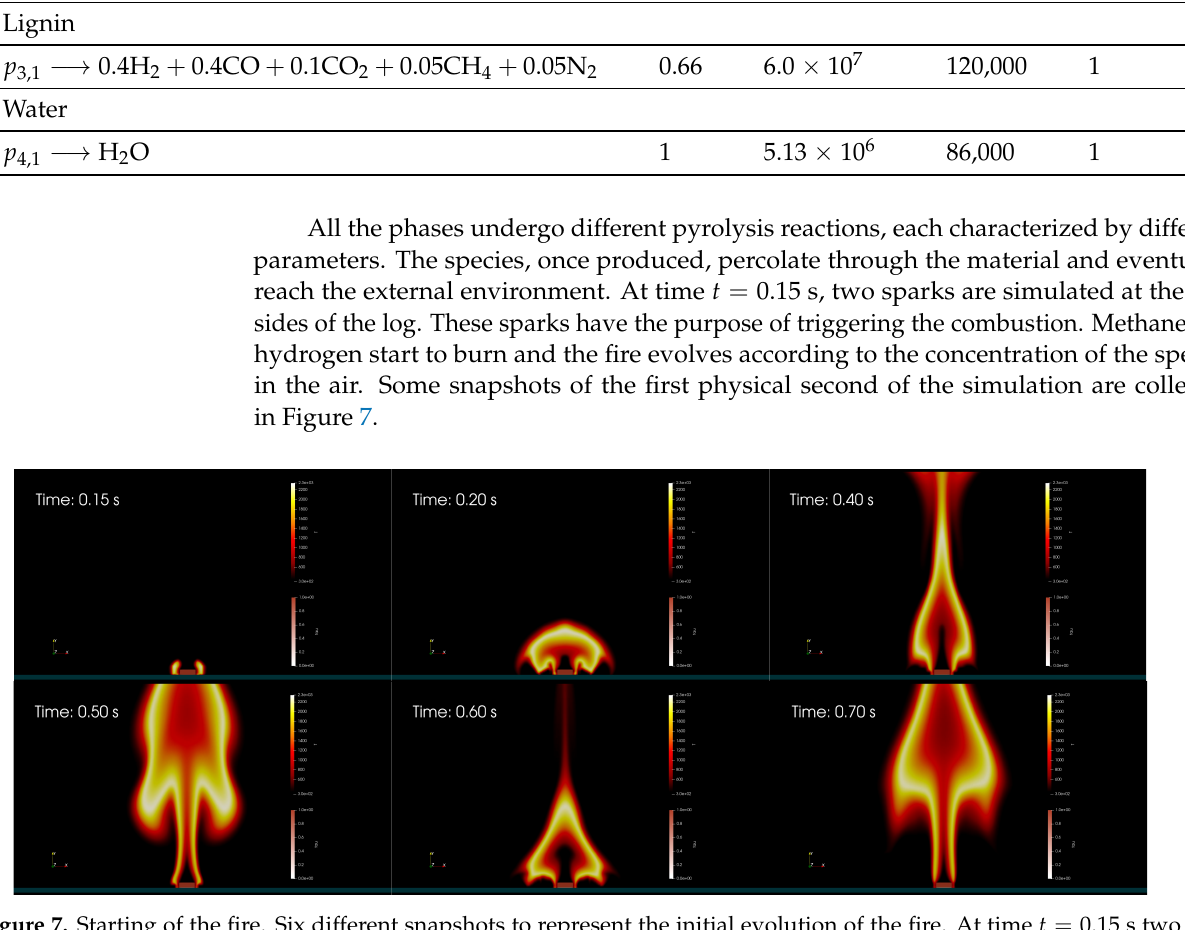
Figure 7. Starting of the fire. Six different snapshots to represent the initial evolution of the fire. At time t = 0.15 s two sparks are generated on the side of the wood log to trigger the combustion. A fire is generated and start propagating in the domain. By comparing the time t = 0.50 s with the time t = 0.70 s it is possible to observe the periodic behavior of the flame, the puffing